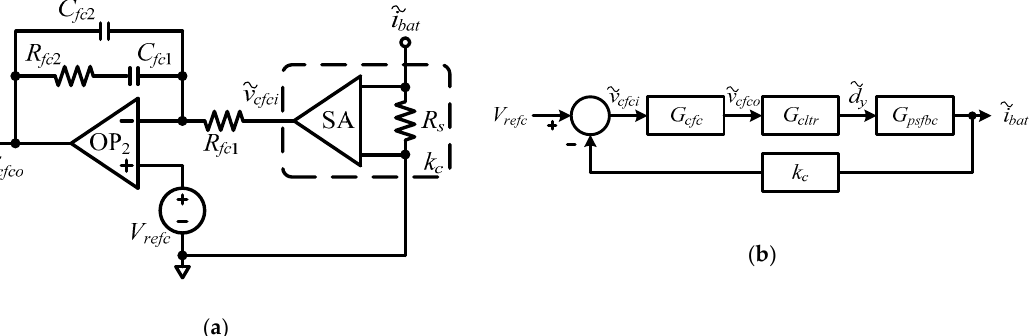
( b ) Figure 18. During start-up phase, different control technologies result in current overshoot occurrence. ( a ) Normal PI design. ( b ) Using the ZBFS method. Figure 19a shows the CFC circuit with PSPI control composed of an operational amplifier OP 3 , compensative elements ( Z in , Z fc 1 , and Z fc 2 ), and the I o ( ref ) . Using Z in and Z fc 2 can yield the P gain to implement the P control; the Z in combines Z fc 1 with Z fc 2 can achieve the PI control. Moreover, the shifting certification for the S cfc is defined as follows:   